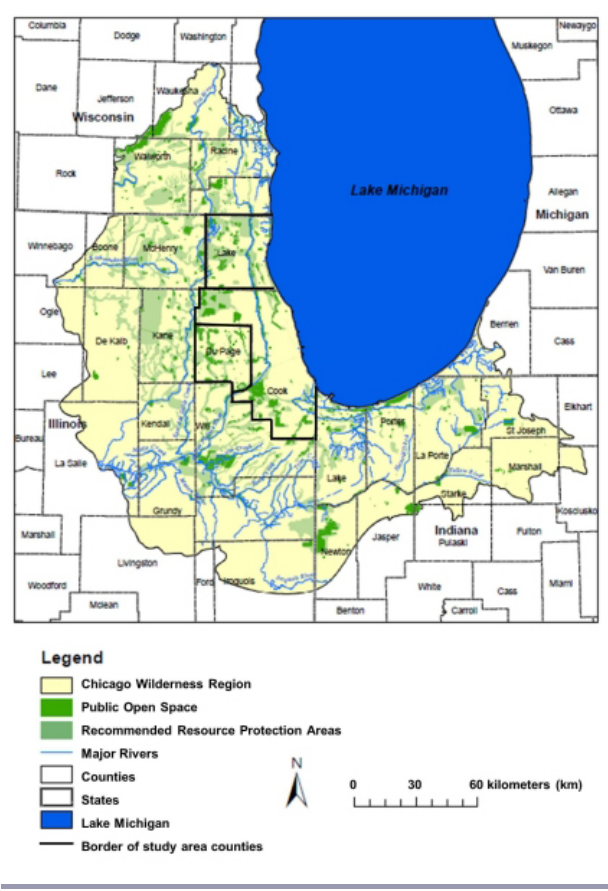
Fig. 1 . Study areas within the Chicago Wilderness